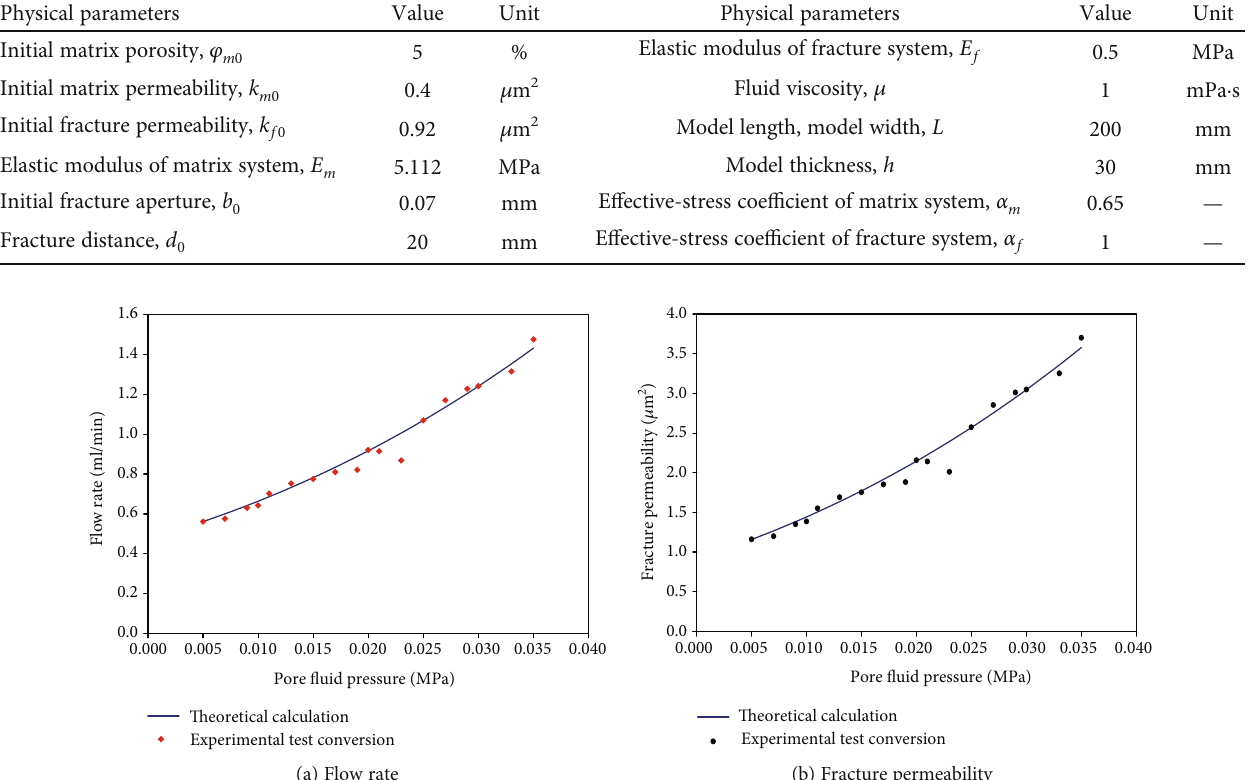
Table 3: Summary of the parameters used in the model.